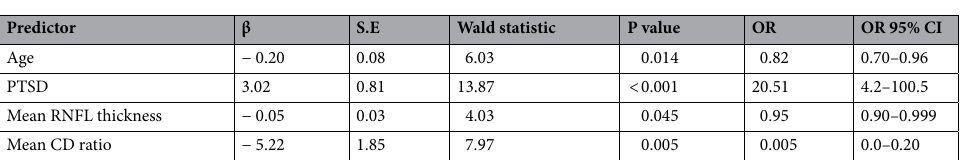
Table 2. Results of forward stepwise binary logistic regression analysis for predictors of Gulf War Illness. PTSD post-traumatic stress disorder, RNFL retinal nerve fiber layer, CD cup-to-disc, OR odds ratio, CI confidence interval, S.E. standard error for